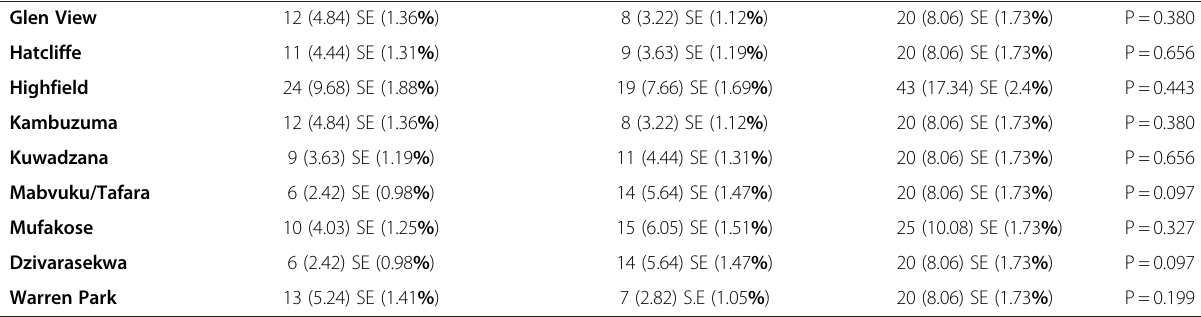
Table 1 Demographic characteristics of the study participants (Continued)